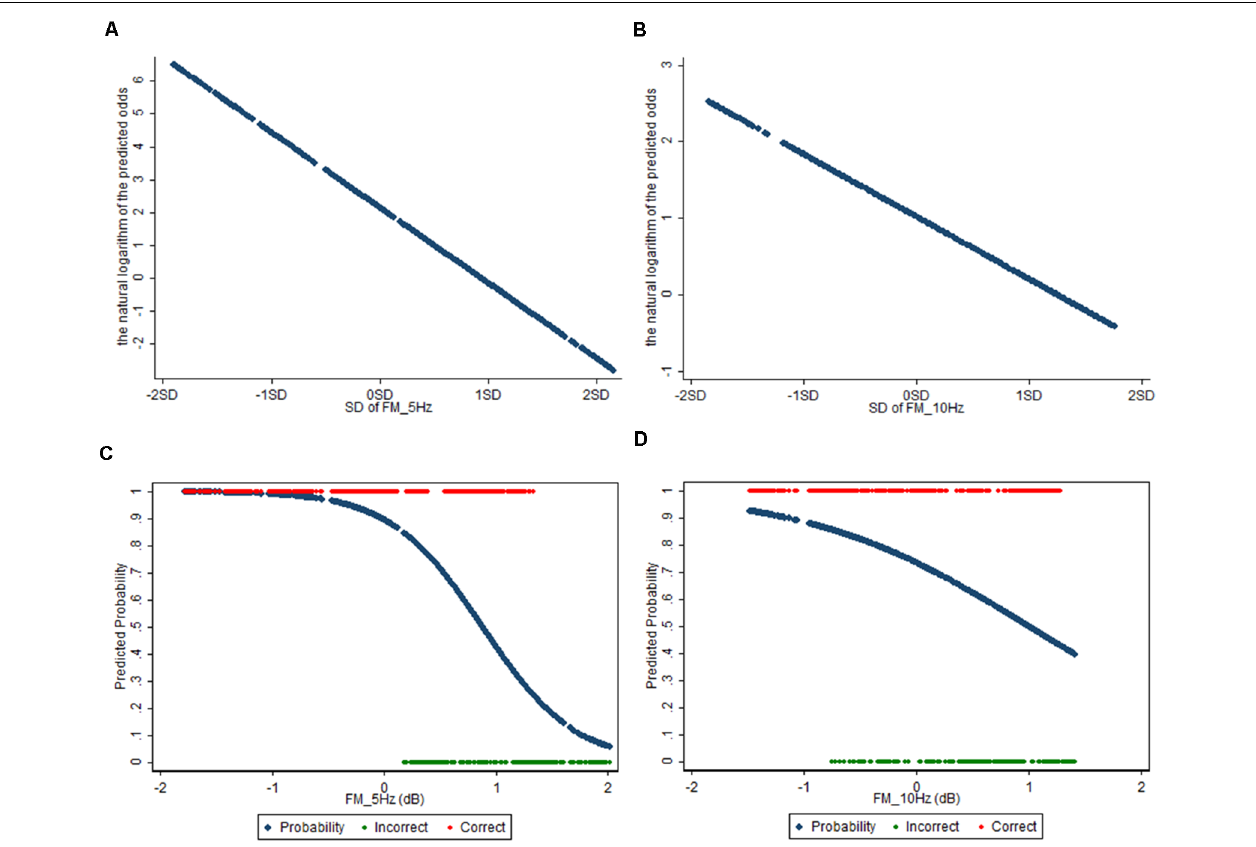
FIGURE 5 | (A,B) The plots show the estimated odds of the response accuracy according to the standard deviation of the frontal midline theta (5 Hz; A ) and alpha 10 Hz power (B) across trials. (C,D) The plots show that the predicted probability of correct responses (blue color) according to the frontal midline theta 5 Hz (C) and alpha 10 Hz power (D) across trials in blue color. The observed correct and incorrect responses are presented in red and green color, respectively.